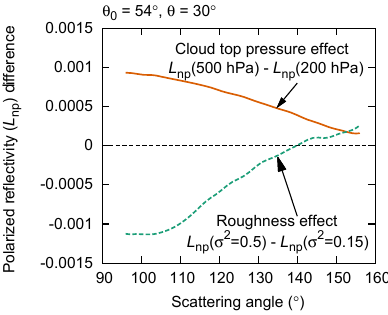
Figure 8. The impact of particle roughness parameter change ( σ 2 = 0 . 15 → 0 . 5 ) and cloud top pressure change (200 → 500hPa). The magnitudes of the differences are comparable while the directional patterns are different. In this plot, the solar zenith angle is 54 ◦ and the viewing zenith angle is 30 ◦ .